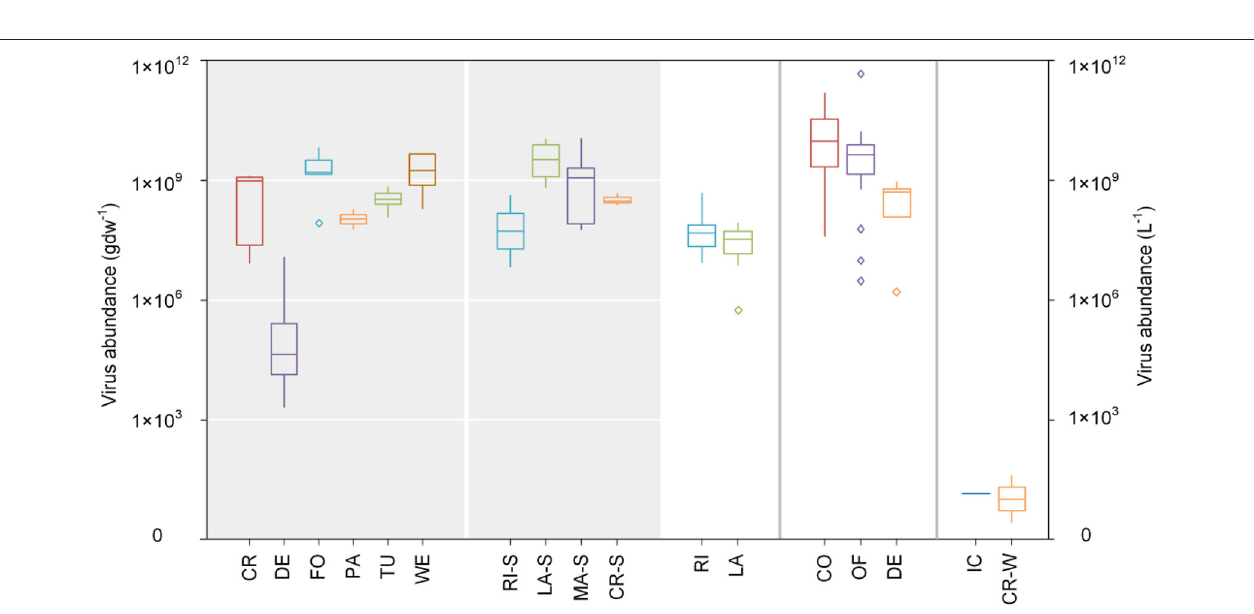
FIGURE 3 | Virus abundance within different ecosystems. Grayed and transparent areas represent virus abundance values in solid and liquid matrices, respectively. All data in this figure were obtained through logarithms. CR, cropland; DE, Desert; FO, Forest; PA, Pasture; TU, Tundra; WE, Wetland; RI-S, River-Sediment; LA-S, Lake-Sediment; MA-S, Marine-Sediment; CR-S, Cryoconite holes-Sediment; RI, River; LA, Lake; CO, Coastal; OF, Offshore; DE, Deep sea; IC, Ice; CR-W, Cryoconite holes-Water. See Supplementary Table S3 for data sources.